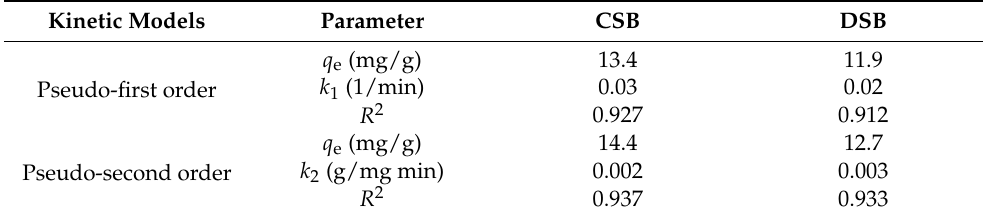
Table 2. Adsorption kinetic parameters of 17 β -estradiol (E2) on corn straw and dewatered sludge biochars (CSB and